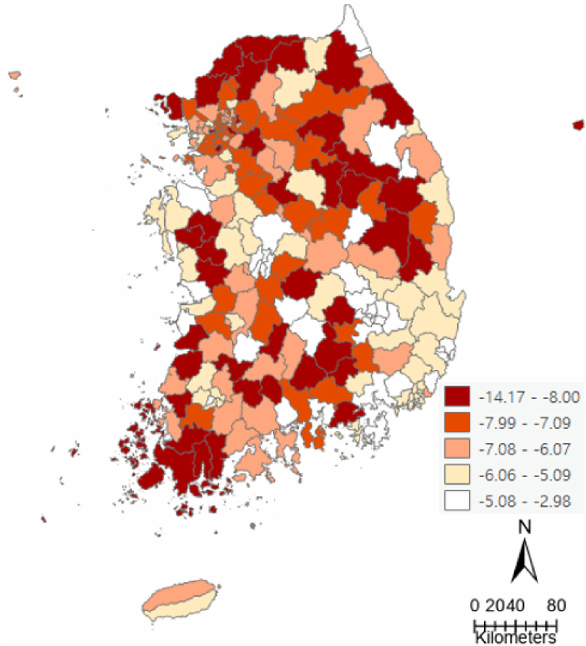
Fig. 1 Regional distribution of health screening participation rate di ff erence (2020 –